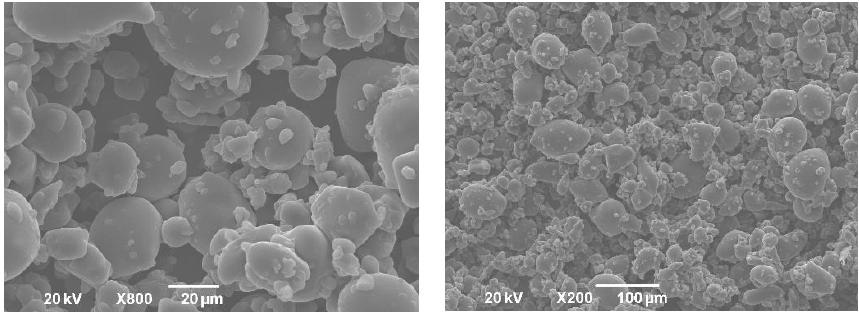
Figure 4. SEM pictures of dry gentian extract powder.